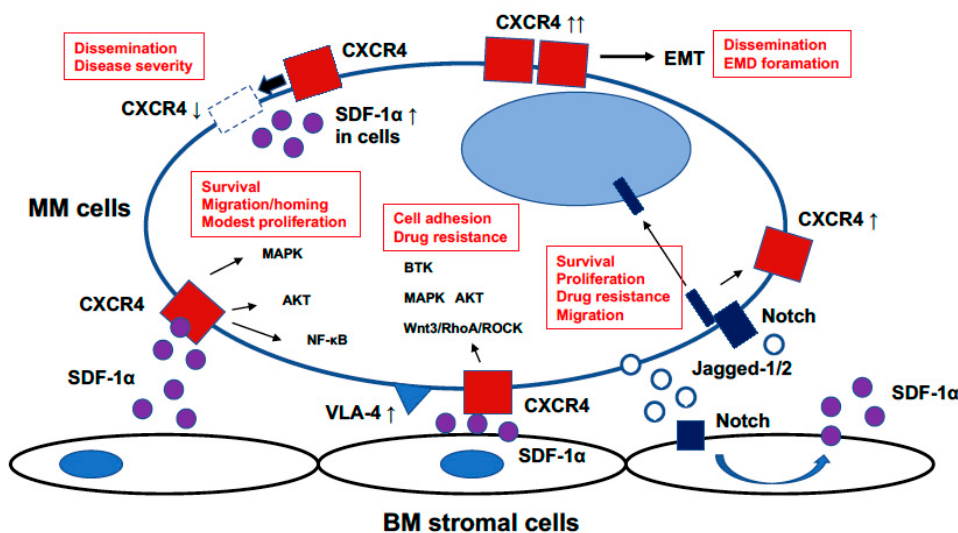
Figure 1. Pleiotropic roles of Stromal cell-derived factor-1 α (SDF-1 α )/C-X-C chemokine receptor type 4 (CXCR4) axis in multiple myeloma cells. SDF-1 α /CXCR4 axis plays pleiotropic roles in multiple myeloma (MM) pathogenesis including proliferation, survival, migration, homing, drug resistance, epithelial-mesenchymal transition (EMT), dissemination, and extramedullary disease (EMD) formation.